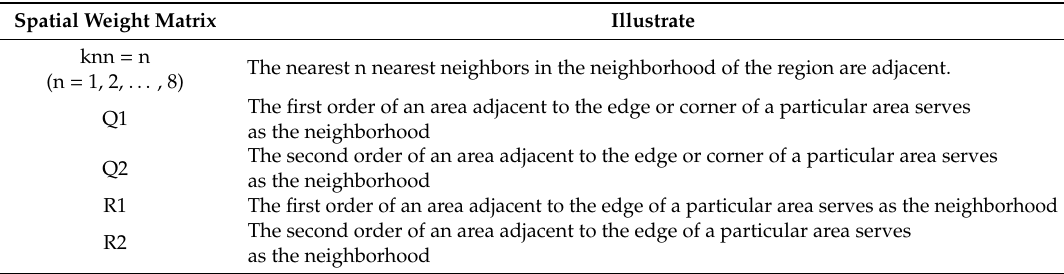
Table 1. Alternative space weight matrix